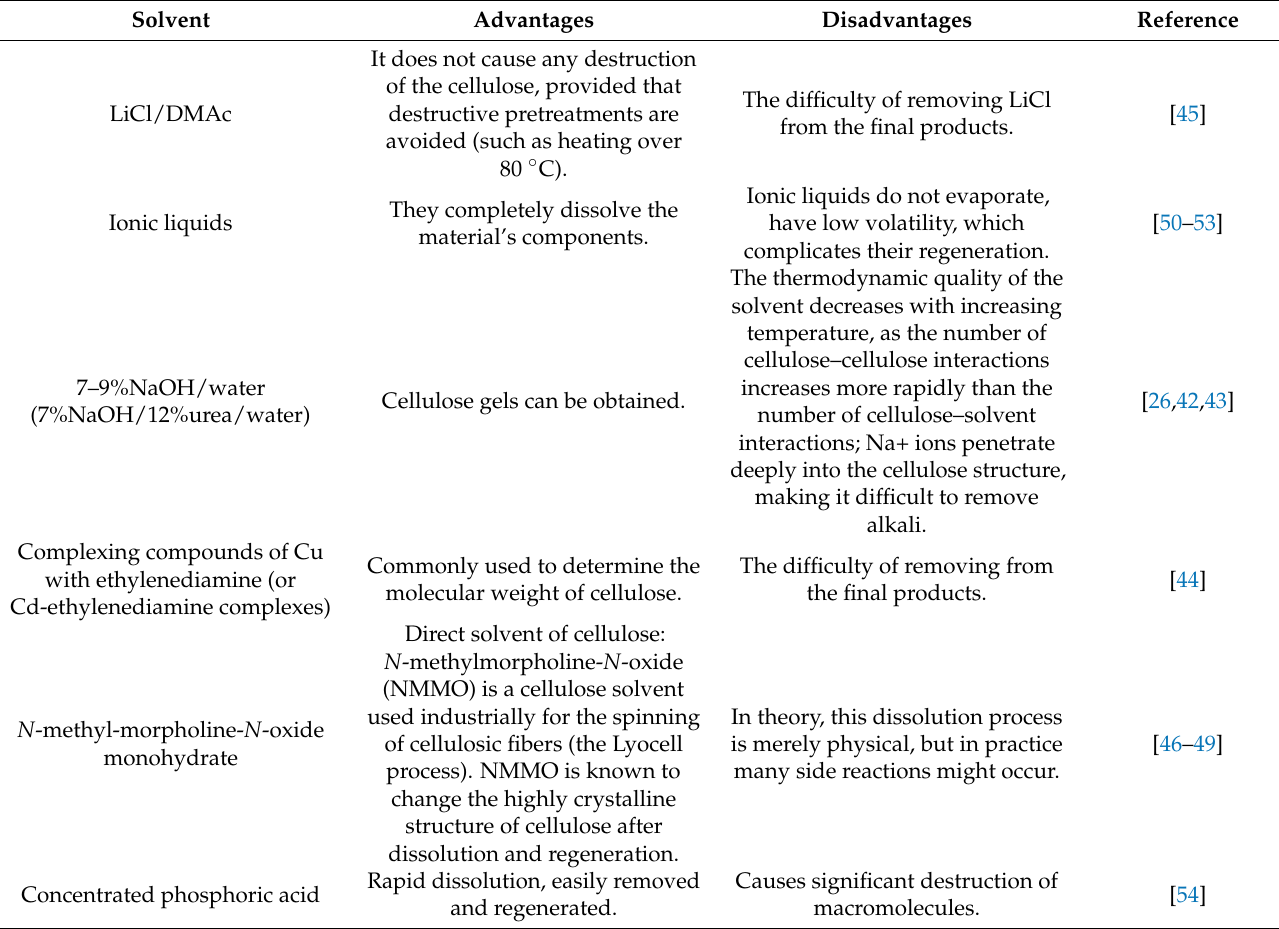
Table 1. Characteristics of typical cellulose